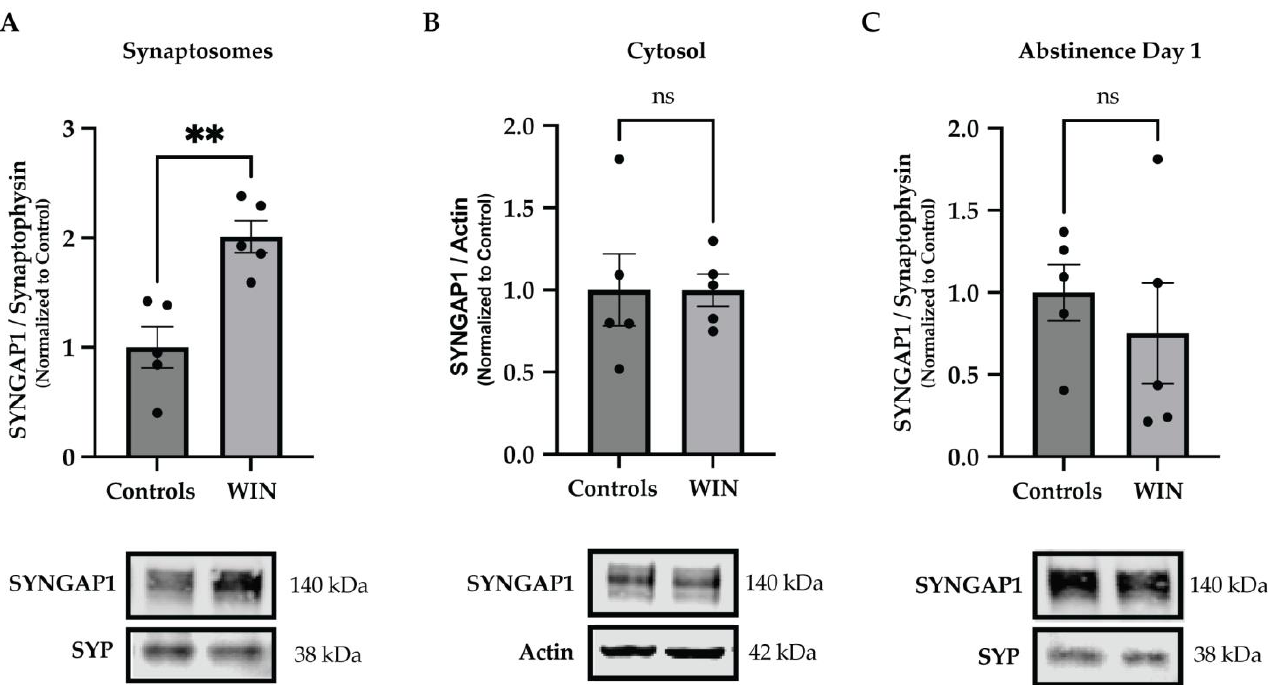
Figure 2. Exposure to WIN in adolescence results in upregulation of synaptic SYNGAP1 following drug abstinence. The ANOVA model applied to the synaptoproteomics data revealed that SYNGAP1 was among the most significant differentially expressed proteins in the PFC of WIN-treated animals compared to controls following 12 days of drug abstinence (ANOVA, q = 0.00000679; Supplementary Dataset S2). ( A ) Western blotting experiments using synaptosomal lysates of the PFC confirmed significant changes in levels of SYNGAP1 in the WIN-treated group compared to controls following 12 days of drug abstinence (n = 5 animals per group). ( B ) Western blotting experiments using cytosolic lysates of the PFC showed no changes in levels of SYNGAP1 in the WIN-treated group compared to controls following 12 days of drug abstinence (n = 5 animals per group), suggesting that the WIN-induced changes in SYNGAP1 are spatial in nature. ( C ) No changes were found in levels of SYNGAP1 when Western blotting experiments were performed using synaptosomal PFC extracts from animals sacrificed the day after the last WIN exposure, i.e., on abstinence day 1 (n = 5 animals per group), suggesting that the WIN-induced changes in SYNGAP1 are also temporal in nature. Graph data are presented as mean ± SEM. Representative Western blots are shown below the graphs, with the approximate molecular weights of observed band sizes indicated to the right. kDa, kilodaltons; ** p < 0.01, and ns = not significant.